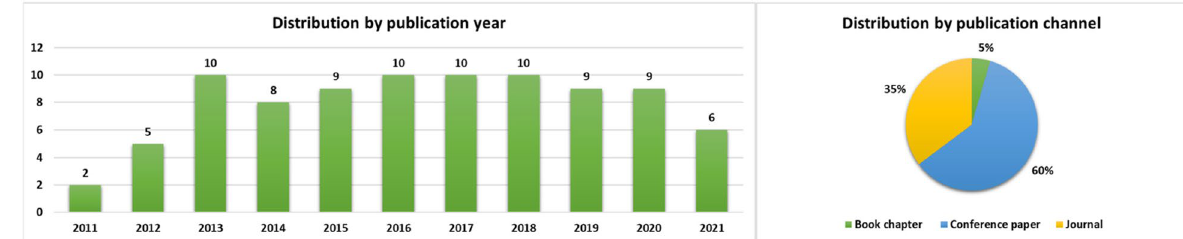
Fig. 11 Distribution by publication year and by publication channel (total number;